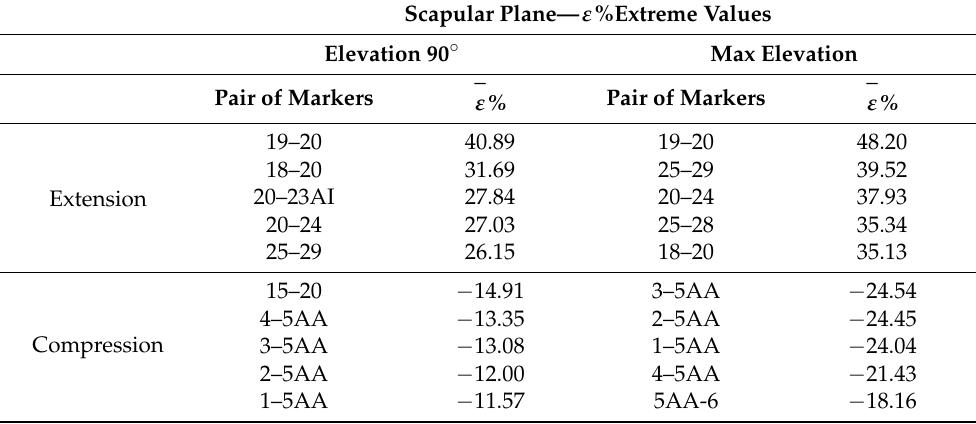
Table 5. Extreme percentage values of the mean strain ε % in both extension and compression during tasks performed in the scapular